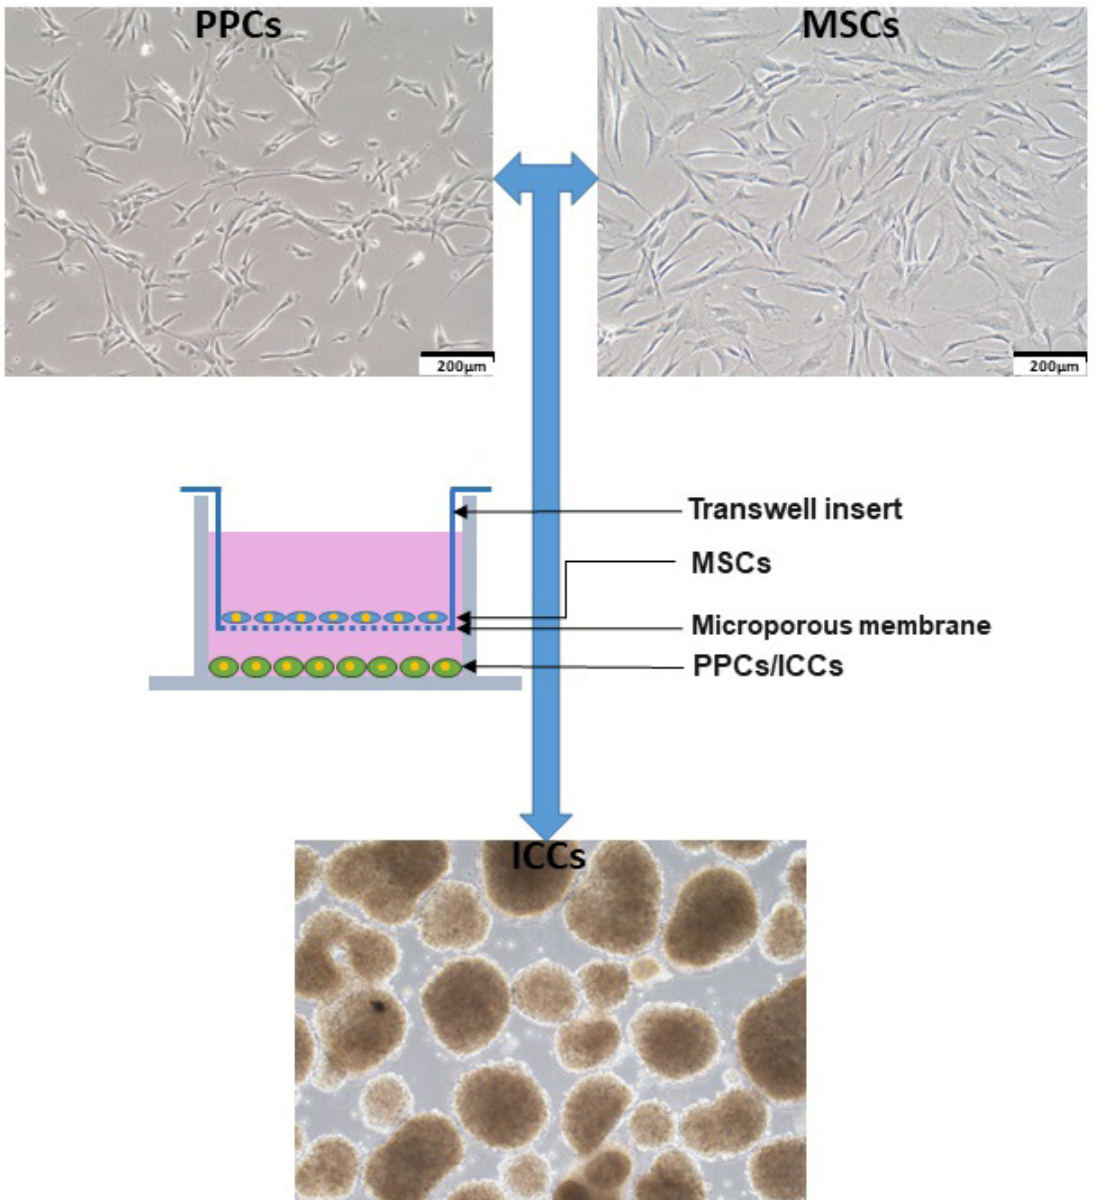
Figure 10. A schematic diagram depicting the set-up and composition of the co-culture system.